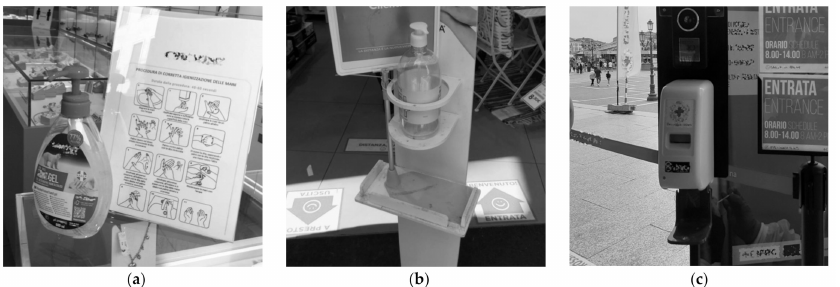
Figure A1. Images illustrating the three sub-categories for the hand-sanitizing systems: simple dispensers activated by pushing and not integrated in a specific structure or system (A1) ( a ); hand-sanitizer dispenser activated by pushing but positioned in an ad hoc structure or system (A2) ( b ); and touchless hand sanitizers integrated in an ad hoc structure or system (A3) ( c